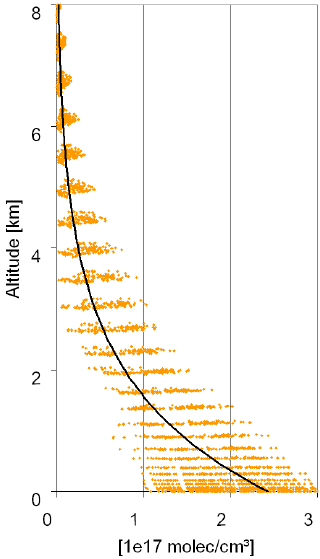
Fig. 20. H 2 O concentration profiles (from ECMWF data) above Mainz duringJune 2011. The black line represents an exponential fit to the data; the respective scale height is 1.77 km.